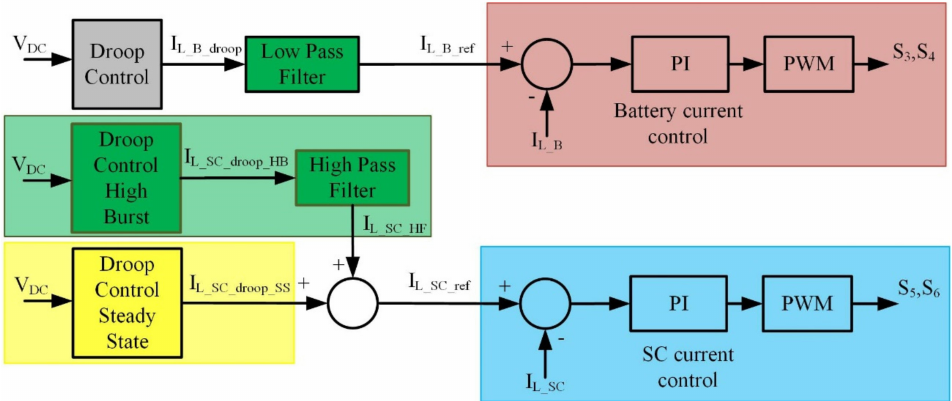
Figure 4. Block diagram for the proposed control scheme of HESS. (Remove LPF from